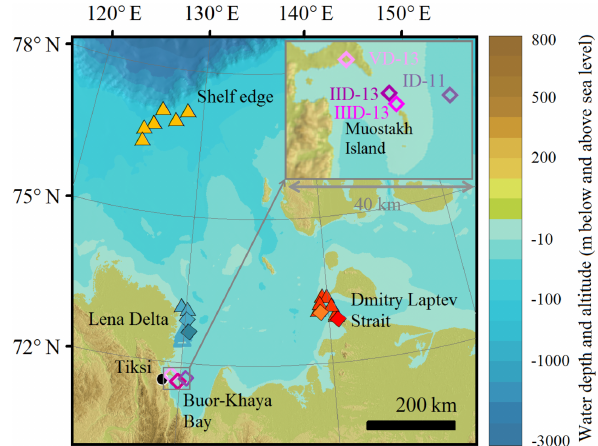
Figure 1. Sampling location. Water sampling (triangles), sediment drilling (diamonds). Summer sampling (close symbols) and winter sampling (open symbols). The color legends of the deep sediment cores are shown on the top